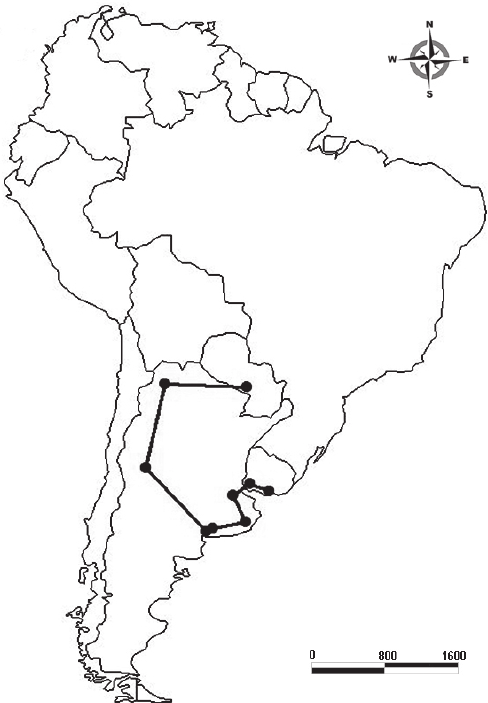
Fig. 21 - Individual track of Scelidotherium leptocephalus .